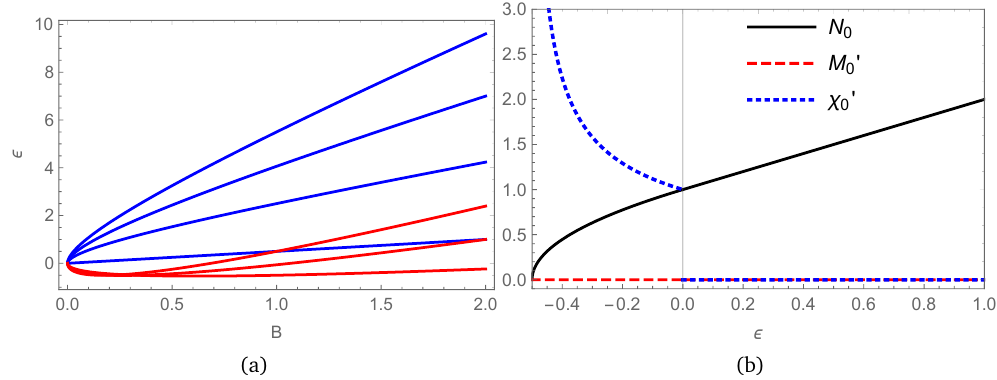
[ in units of m ] as a function of the magnetic Figure 5: Rashba model. (a) Landau levels ε ¯ n , λ 2 ] for ¯ n = 0,1,2,3 when λ = + [ in blue ] and for ¯ n = 1,2,3 when λ = − field B [ in units of m 2 π [ in red ] . (b) Integrated density of states (IDoS) N [ black full line, in units of m 2 0 = 0 [ red dashed line ] and derivative of the susceptibility χ (cid:48) of the magnetization M (cid:48) 0 π dotted line, in units of and for ˜ g = 0 ] as a function of the energy ε [ in units of m ] . Compare m 2 with [ 28 ]